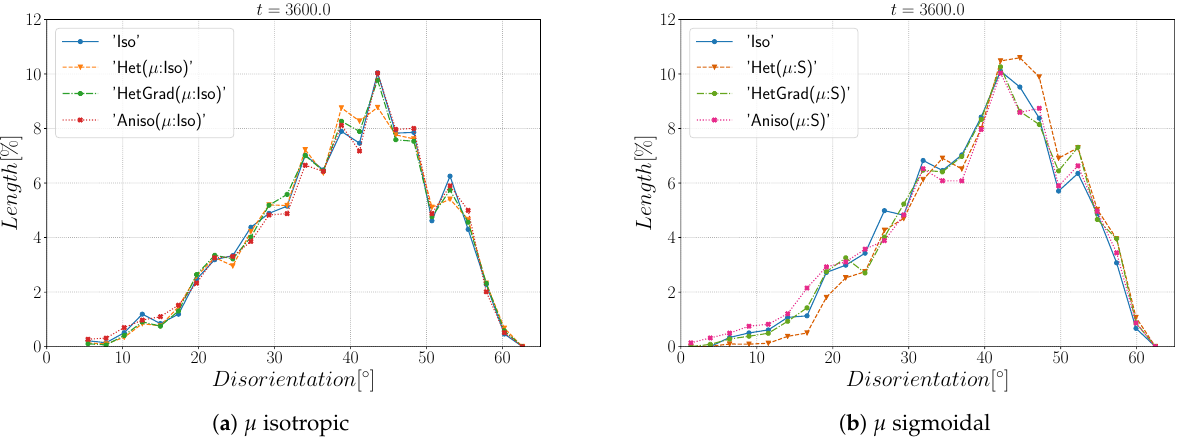
Figure 19. Disorientation distribution function at t = 1h using an isotropic ( a ) and a heterogeneous ( b ) mobility.